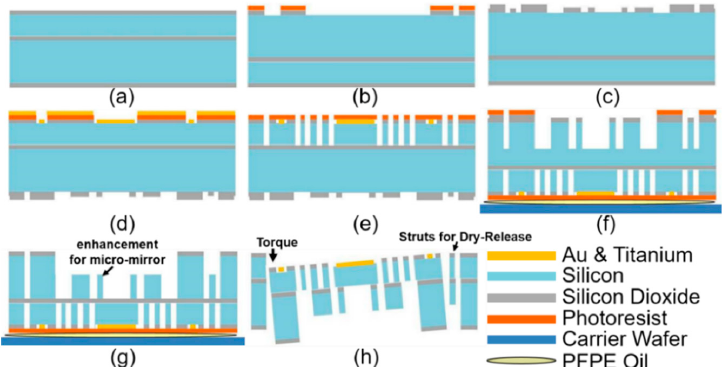
Figure 4. Dicing-free single SOI-wafer-based microfabrication process flow for the 2D patterned Au-coated resonant MEMS scanner with backside enhancement structures. ( a ) Wafer cleaning and the SiO 2 hard mask layer preparation on both sides of the SOI wafer using LPCVD; ( b ) patterning the backside SiO 2 hard mask for the scanner’s full chip frame on the handle silicon layer (Mask 1, handle silicon chip frame); ( c ) patterning the backside SiO 2 -based hard mask (Mask 2, island); this SiO 2 layer was prepared by PECVD; ( d ) lift-off process for a patterned Au/Ti coating (1000 Å/50 Å) to form the reflective surface for the NIR light and the alignment marks on the scanner (Mask 3, Au coating); ( e ) front-side DRIE process on the device silicon layer (Mask 4, device silicon); ( f ) DRIE process on the backside handle silicon layer; the PFPE oil was used for enhancing the thermal conductivity between the SOI and the carrier wafer; ( g ) DRIE process on the backside handle layer till reaching the buried oxide layer; ( h ) wet etching of the SiO 2 under the scanning micro-mirror using buffered hydrofluoric acid (buffered oxide etch (BOE) 7:1); the torque was applied using a sharp tweezer tip to break the struts so that the individual MEMS chip (3.2 by 2.9 mm 2 ) would be dry-released and harvested with a high yield (over 80%).